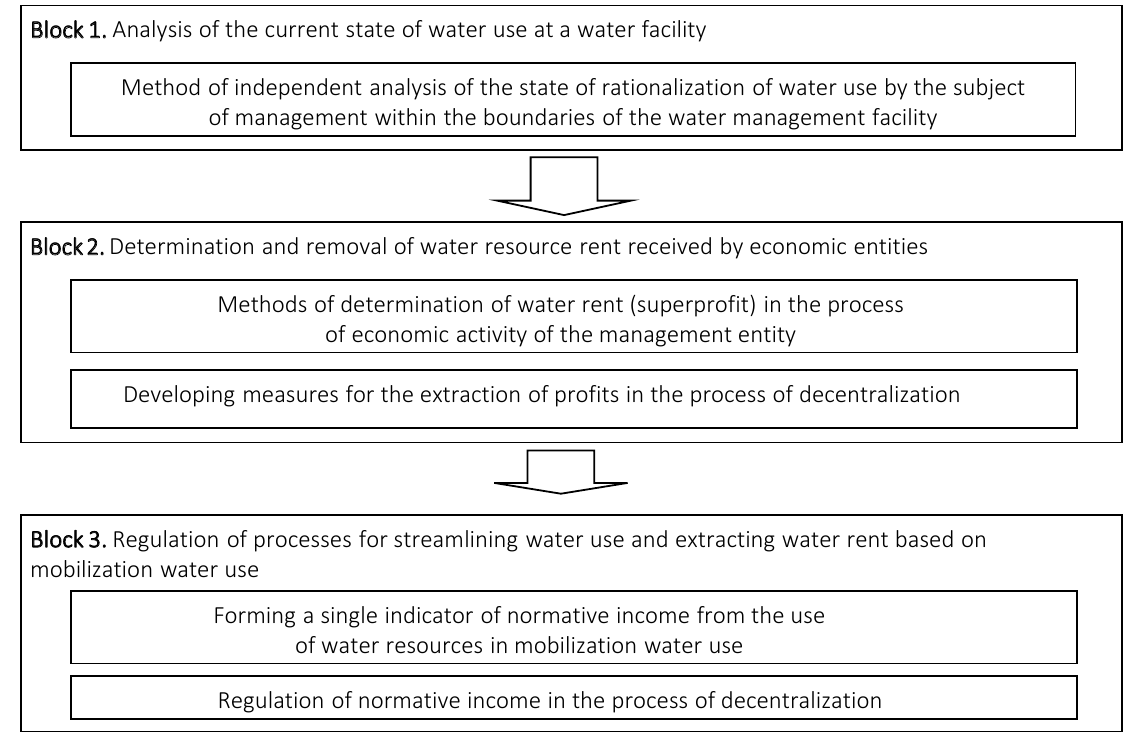
Figure 3. Conceptual scheme of the mechanism of the state policy of water sector development based on the concept of mobilization water use in the process of